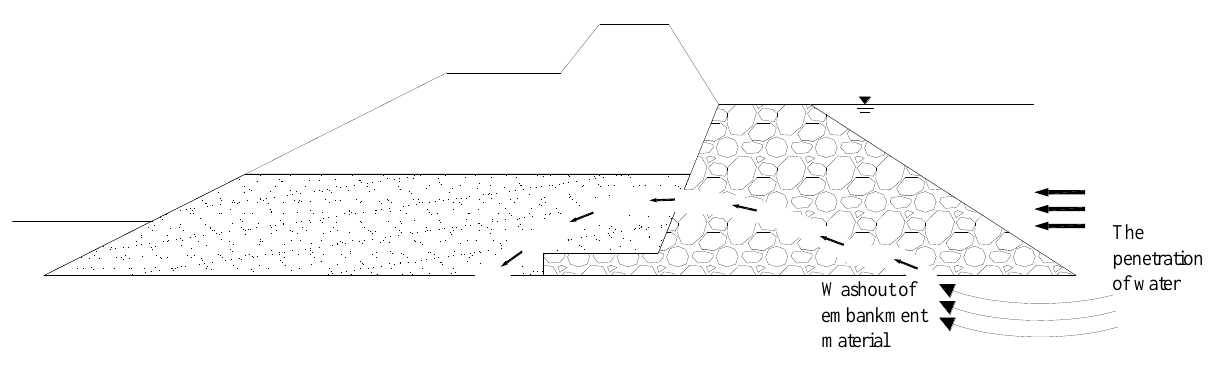
Figure 1. Schematic field conditions.